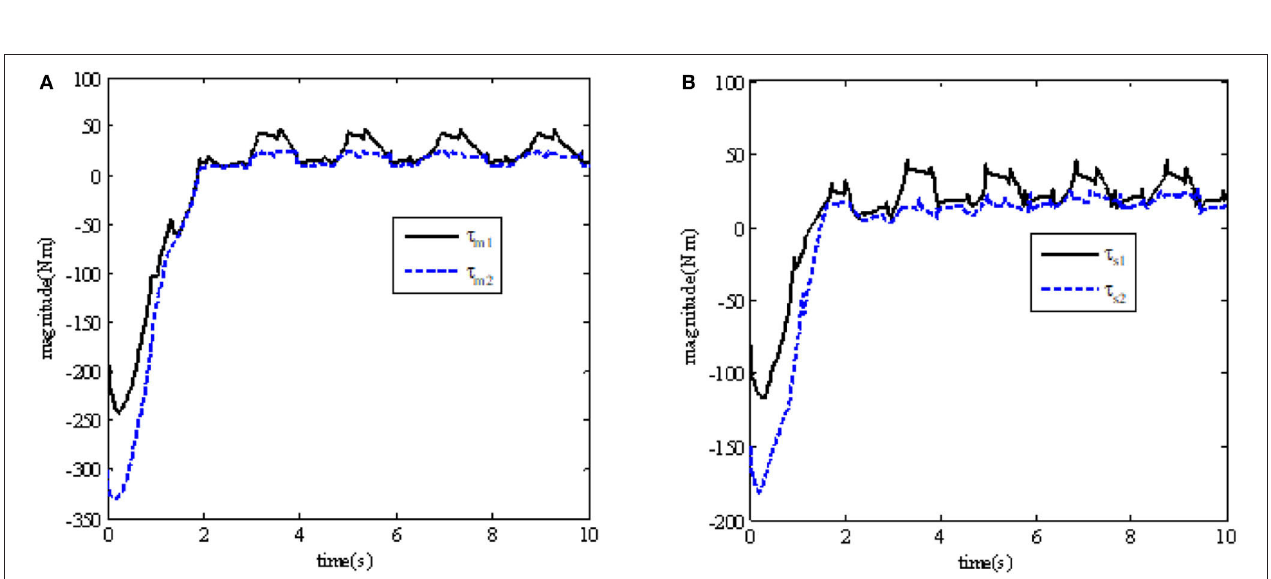
Frontiers in Neurorobotics |